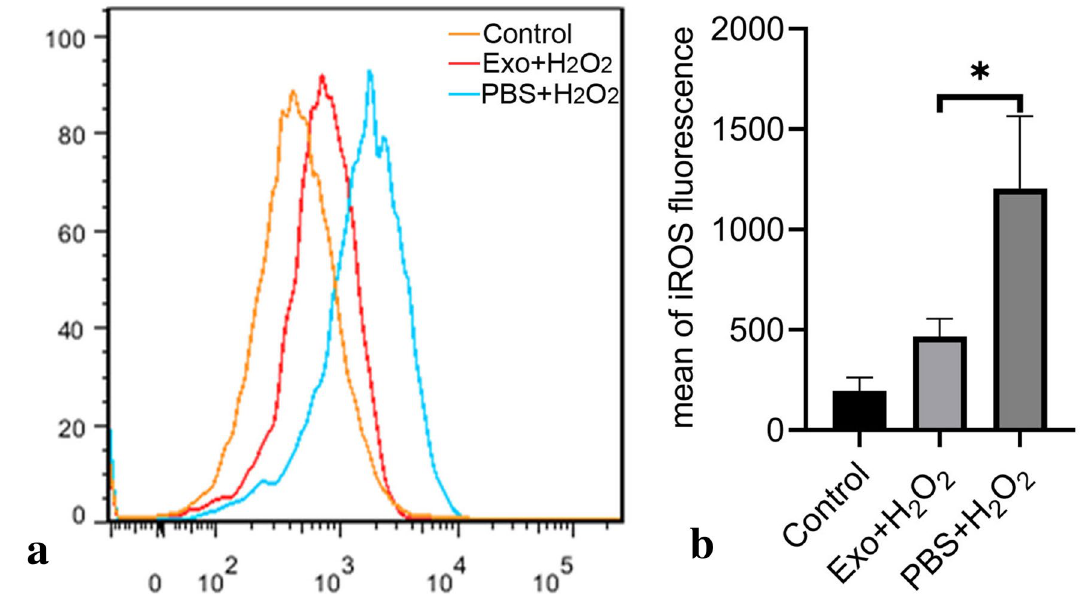
Figure 4. Pretreatment of hBMSC-derived exosomes reduced production of iROS in hTMCs when exposed to H 2 O 2 . HTMCs were pretreated with hBMSC-derived exosomes or PBS for 24 h, then exposed to H 2 O 2 (0.1 mM) for 6 h, and a blank control group cultured with medium containing exosome-free serum. ( a ) Intracellular ROS was identified with DCFDA staining and measured by flow cytometry. ( b ) Quantification of iROS fluorescence. n = 3 for each condition. A P value was obtained by a two-tailed unpaired t-test. *P < 0.05 compared to PBS + H 2 O 2 group. Data were presented in Supplementary Table